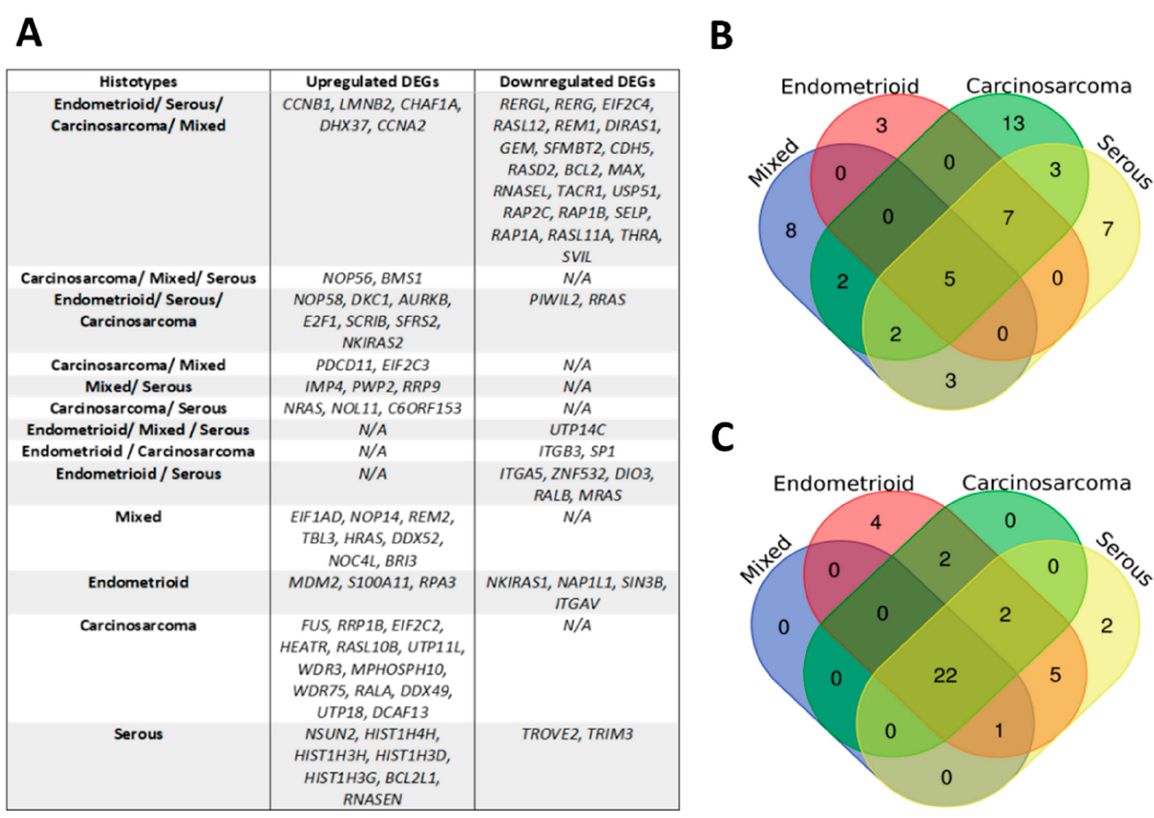
Figure 5. ( A ) Table of DEGs commonly upregulated and downregulated between EC subtypes. Venn diagrams displaying common ( B ) upregulated and ( C ) downregulated genes between each subtype. As endometrioid tumours represent the most common histological subtype of EC, this study furtherexaminedDEGsamongstitsdifferentgrades(Supplementary Figure S3 and Tables